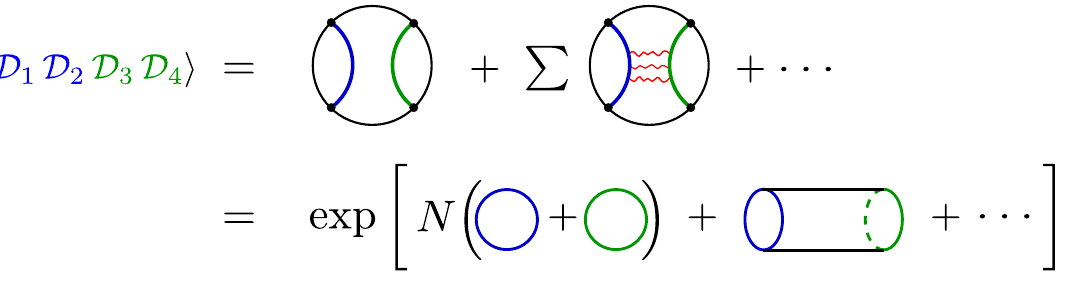
Figure 13 . The four-point function of determinant operators. The leading contribution is given by a disconnected diagram, which corresponds to two disconnected disks from the worldsheet point of view. The next leading contribution is given by a cylinder, which potentially encodes various interesting